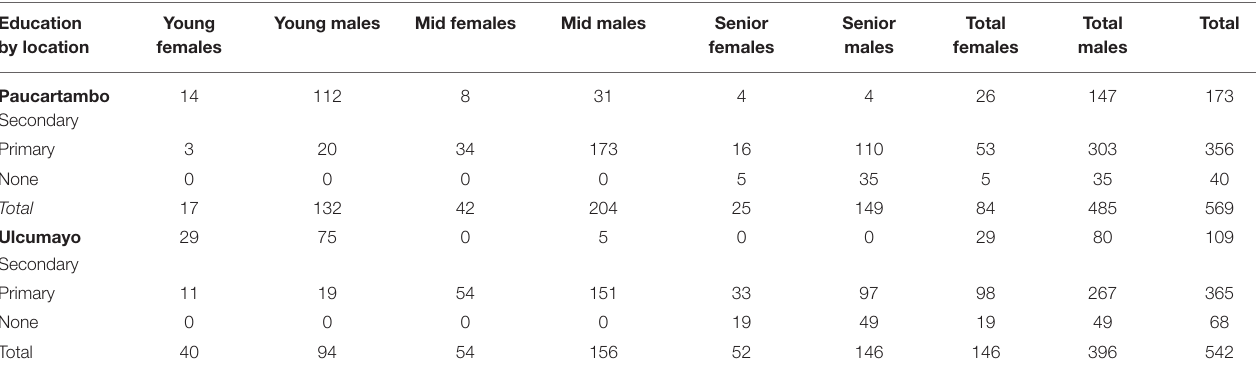
TABLE 1 | Number of respondents with different education levels by age and gender class in Paucartambo and Ulcumayo a . Education by location